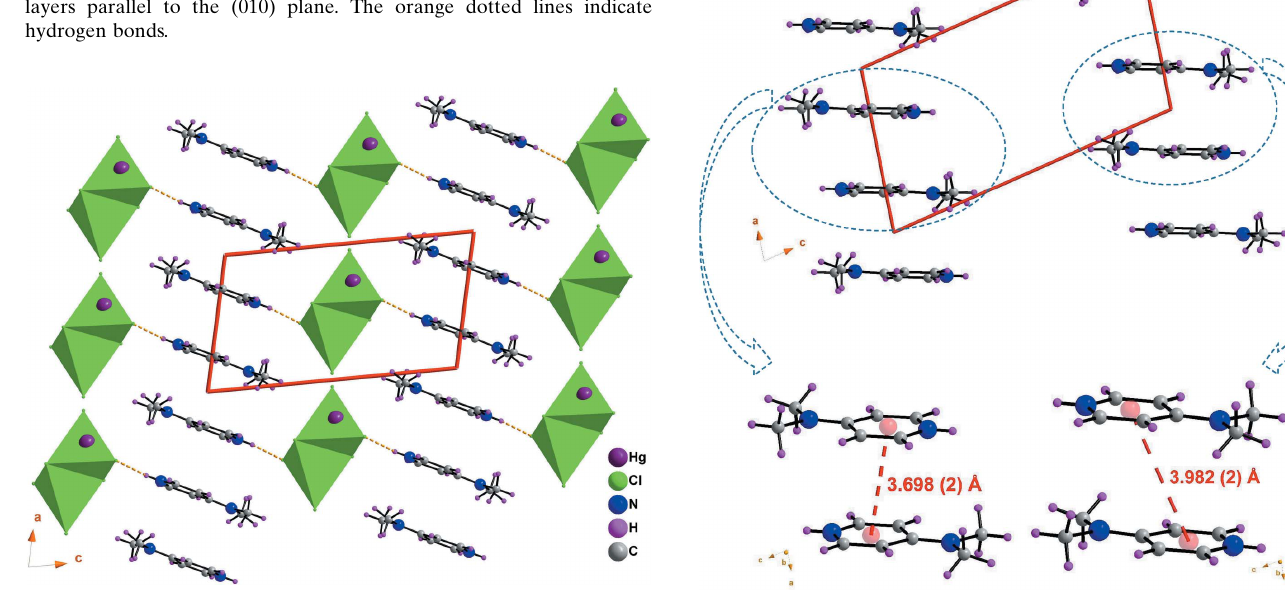
Figure 4 A view of the supramolecular mixed layer in the ac plane of (I), showing the alternating organic and inorganic columns parallel to the [100] direction. The orange dotted lines indicate N—H (cid:3)(cid:3)(cid:3) Cl hydrogen bonds.